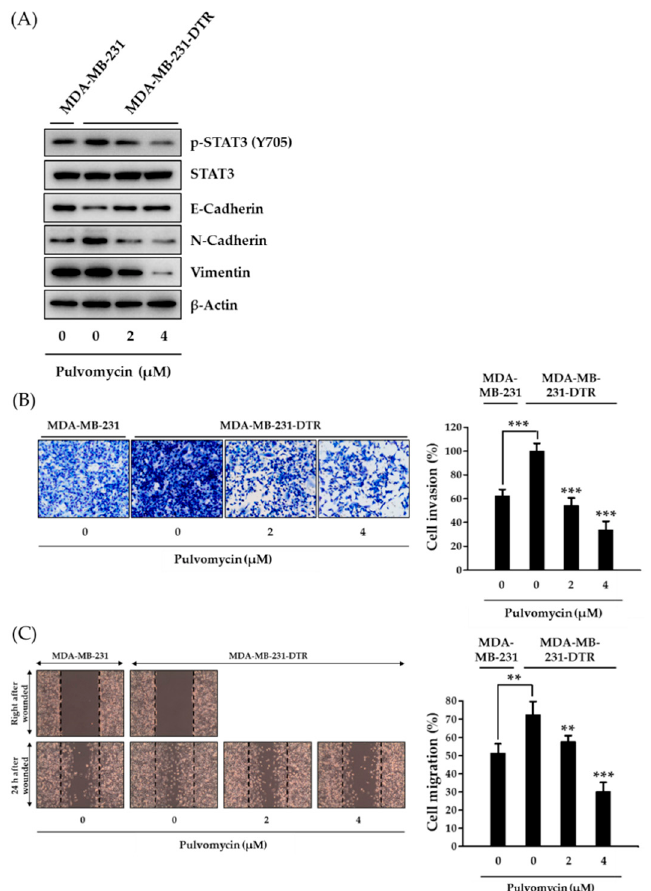
Figure 5. The effects of pulvomycin on epithelial-mesenchymal transition (EMT)-mediated cell invasion and migration. ( A ) The cells were treated with the indicated concentrations of pulvomycin for 24 h, and levels of p-STAT3 (Y705), STAT3, E-cadherin, N-cadherin, and vimentin expression were determined using Western blot analysis. β -Actin was used as an internal control. ( B ) The cells were pretreated with pulvomycin at the indicated concentration for 24 h, reseeded into the upper chambers of Transwell inserts, and incubated for 24 h. Cells that invaded the lower chambers were fixed, stained, imaged (left), and quantified using NIH’s ImageJ v1.52a software (right). Data are presented as the mean ± SD ( n = 3). *** p < 0.001 compared with the control. ( C ) Cell monolayers were mechanically scratched and treated with pulvomycin for 24 h. Representative light microscopy images of wound closure are shown (left). Wound areas were quantified using NIH’s ImageJ v1.52a software (right). Data are presented as the mean ± SD ( n = 3). ** p < 0.01 and *** p < 0.001 compared with the control.